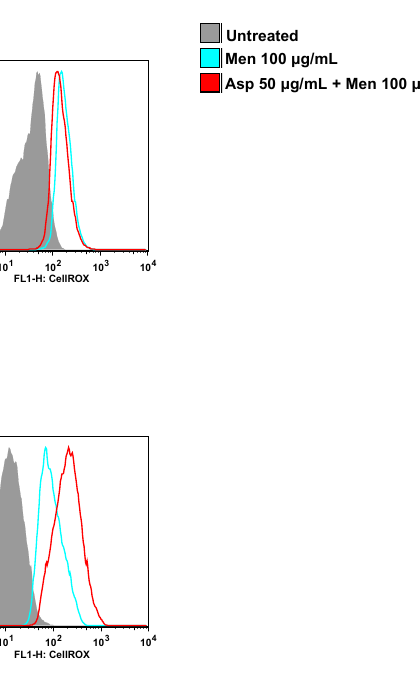
Figure 6. NIH/3T3 ( a ) or MCF7 ( b ) were treated with 50 μ g/mL Asp for 48 h and then triggered with oxidative stimulation performed by Menadione (Men) 100 μ M for 30 min. The left panels reported data as mean ± standard error of results from at least three independent experiments. Right panels: representative flow cytometry dot plots. The axes scale for fluorescence is reported as logarithmic. Statistical analysis was performed by ANOVA followed by Bonferroni post hoc test; * p < 0.05, ** p < 0.01 and *** p < 0.001.